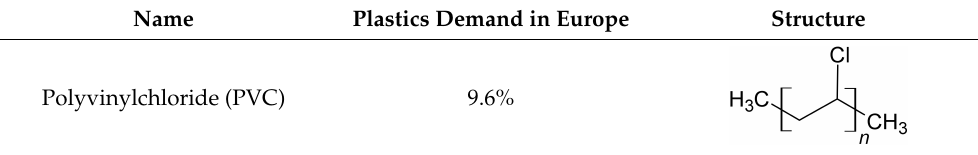
Table 5. European plastic demand and backbone structural formula of